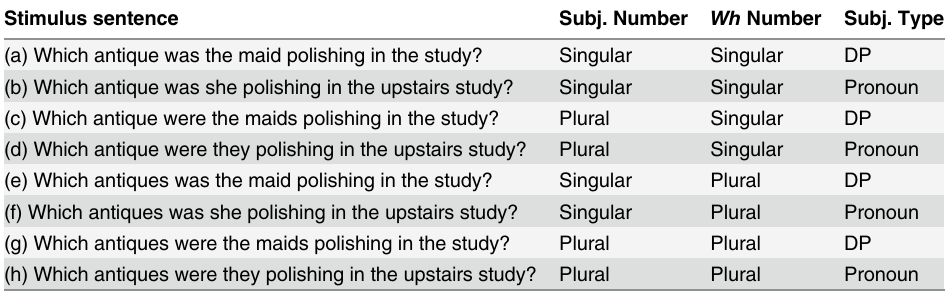
Table 2. Example stimuli set, Experiment